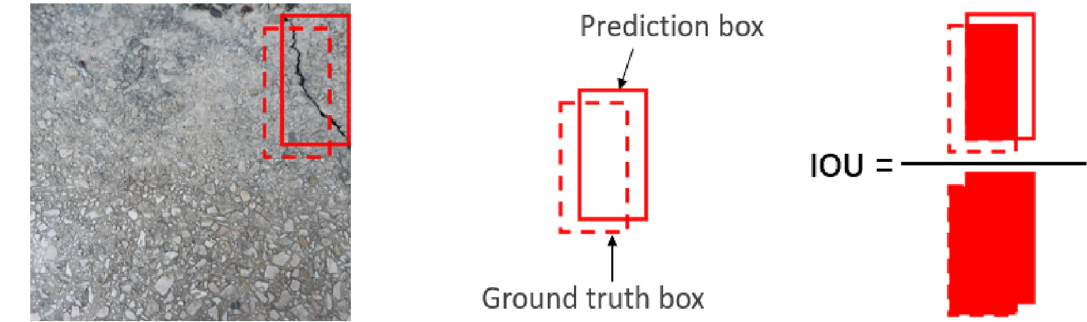
Fig. 7 IOU calculation process